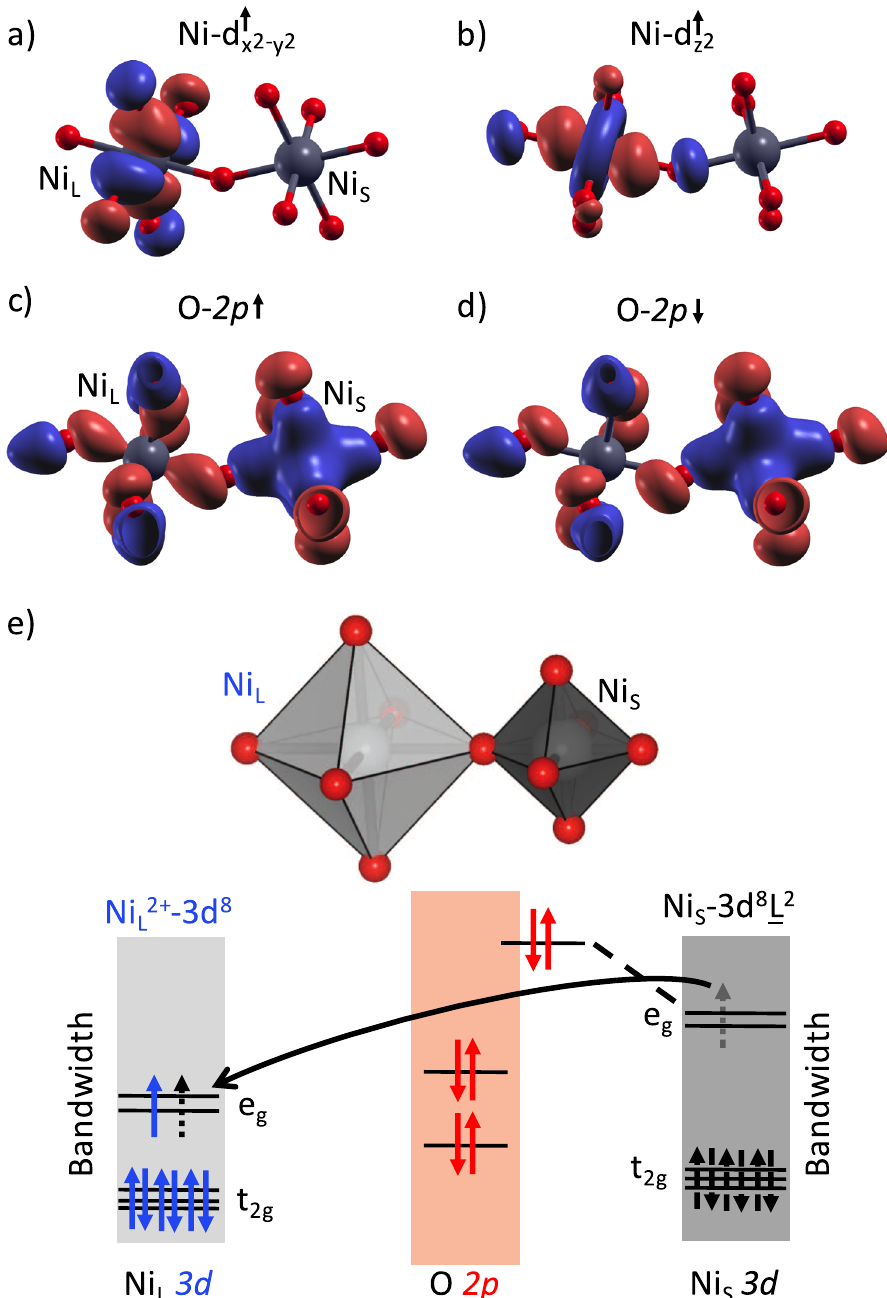
Fig. 4 Orbital occupancies in rare-earth nickelates. a d " MLWF on two consecutive Ni sites. The Ni L site bears a spin up. b d " x 2 (cid:2) y 2 consecutive Ni sites. The Ni L site bears a spin up. c O-2 p MLWFs oriented along the Ni – O bonds on the two consecutive Ni sites in the spin-up channel. d O-2 p MLWFs oriented along the Ni – O bonds on the two consecutive Ni sites in the spin down channel. e Schematic picture of